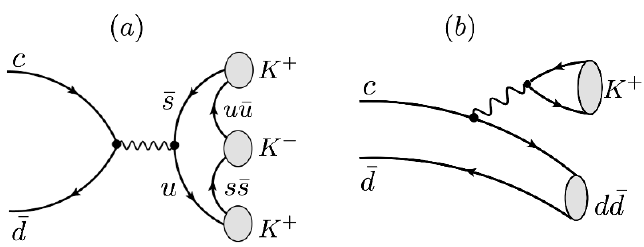
Figure 9 . Diagrams representing the two quark-level topologies for the D + ! K (cid:0) K + K + decay. In the Triple-M [3], diagram ( a ) is assumed to be the dominant mechanism of the decay, whereas diagram ( b ) is suppressed since the production of a K + K (cid:0) pair from a d (cid:22) d pair requires